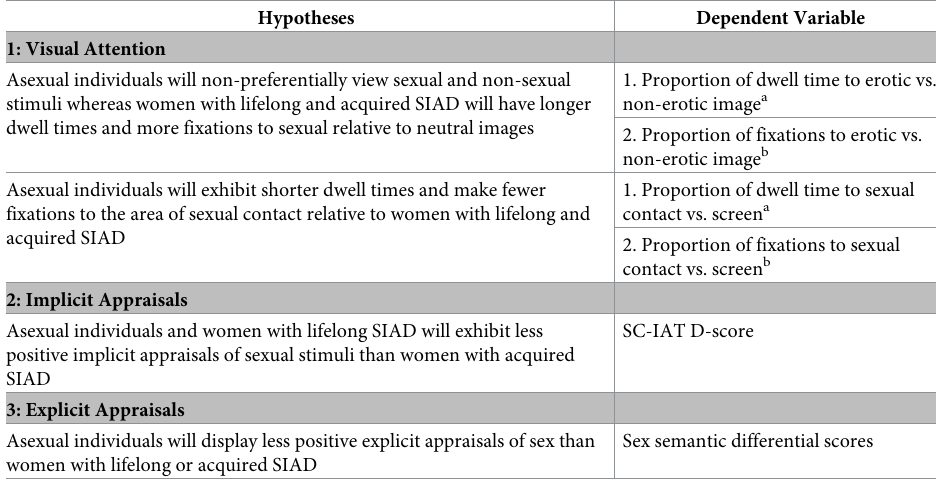
Table 1. Hypotheses and data analyses for primary and secondary